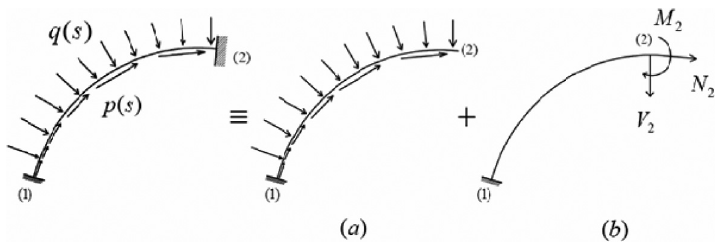
Fig. 5. Force method analysis of a clamped-clamped